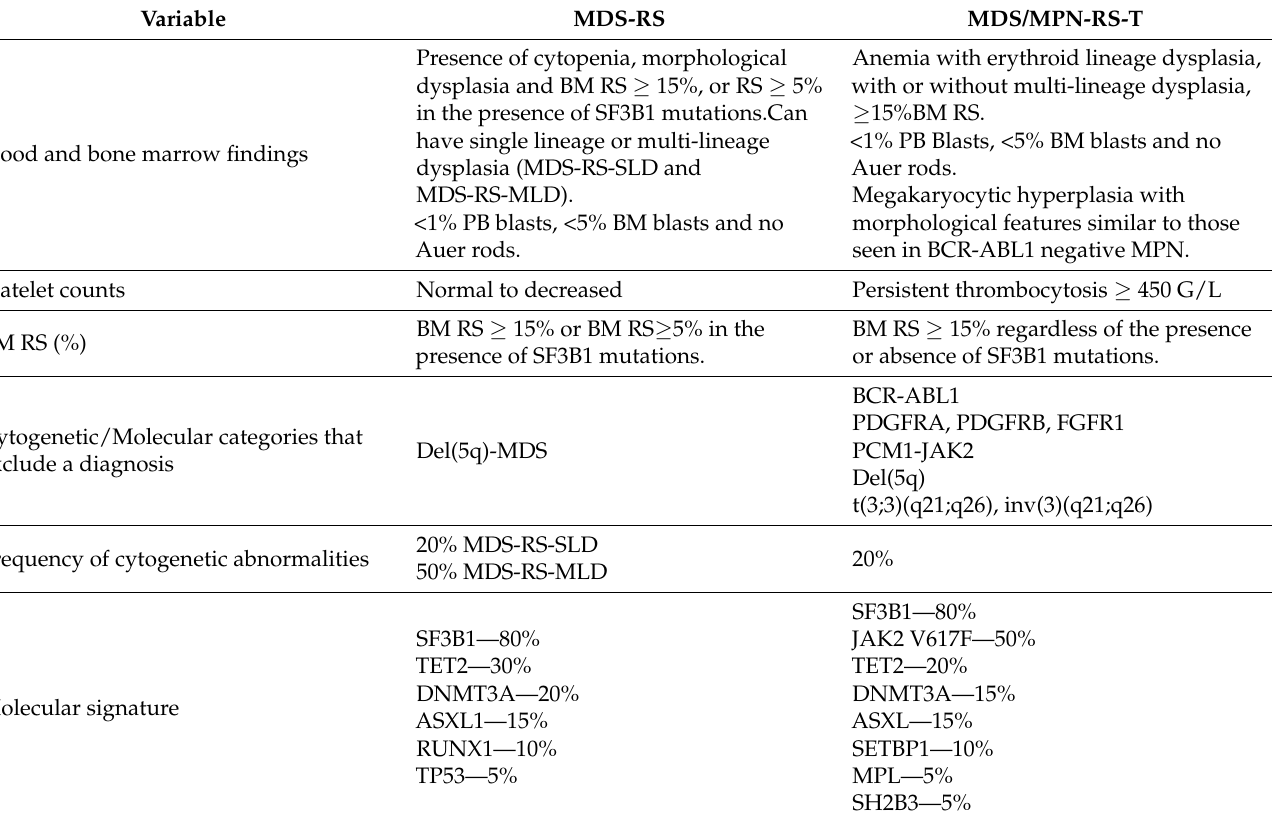
Table 1. Biological features of MDS-RS and MDS/MPN-RS-T (BM: Bone Marrow; PB: Peripheral